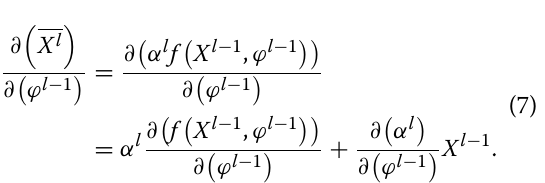
From Eq. (6), the back propagation gradient of MSSA